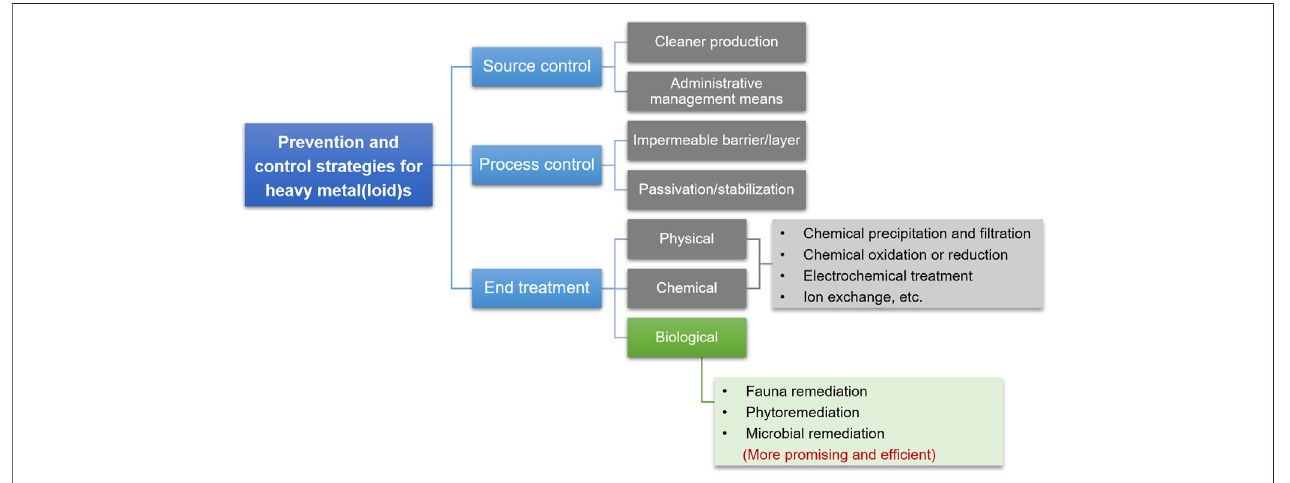
FIGURE 5 | Glimpses of prevention and control strategies for HMs in the environment to mitigate health risks to